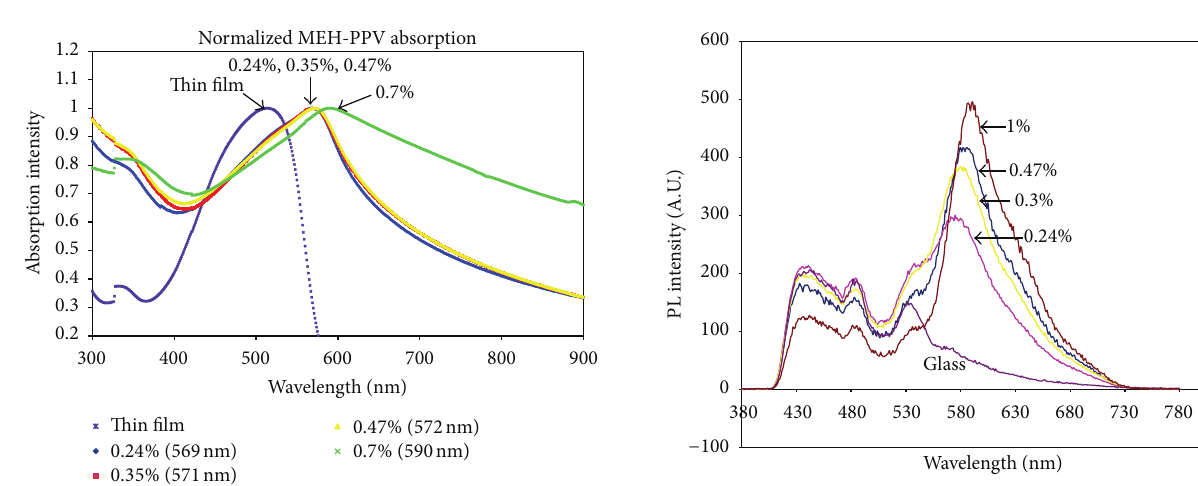
Figure 4: MEH-PPV absorption of 0.24%, 0.35%, 0.45%, and 0.7% concentrations in chloroform. All curves were normalized to their maximum value.